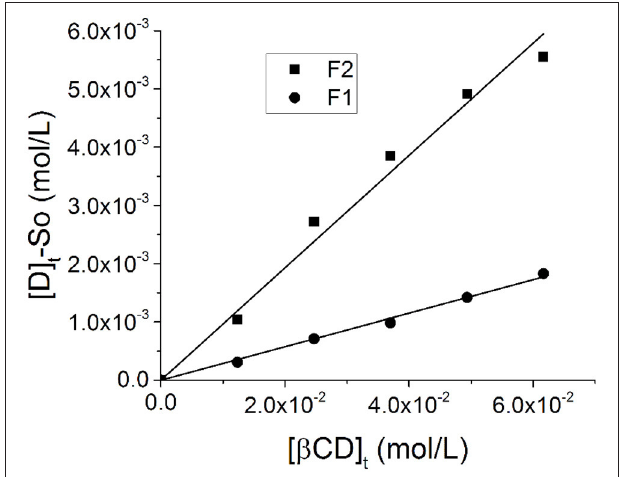
FIGURE 4 | A L -Phase solubility diagram of β F1 ( (cid:8) ) and β F2 ( (cid:4) ) in presence of β CD . [ D ] t corresponded to the total concentration of the guest (mol/L) (i.e., F1 or F2 ); [ β CD ] t corresponded to the total concentration of cyclodextrin in the polymer (mol/L); S 0 (mol/L) was the intrinsic solubility of the guest in water (see Equation 2 ).